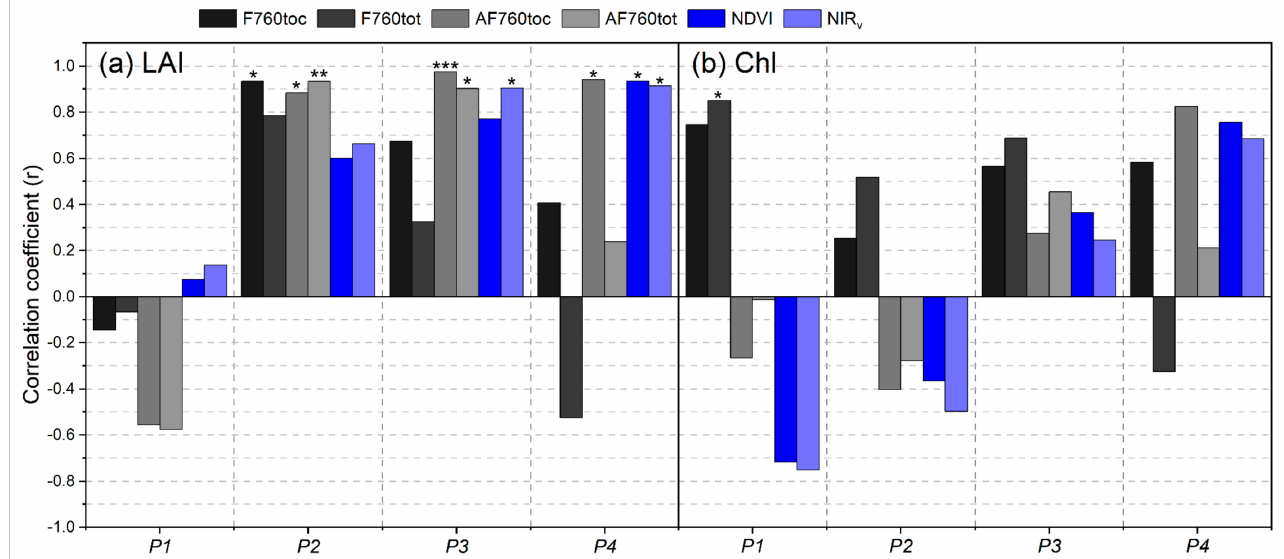
Figure 8. Partial correlation coefficients (r) of ( a , b ) with F760toc, F760tot, AF760toc, AF760tot, NDVI, and NIR v based on daily measurements. Significance was performed according to two-tailed test (ns: p > 0.05. * p < 0.05. ** p < 0.01. *** p <